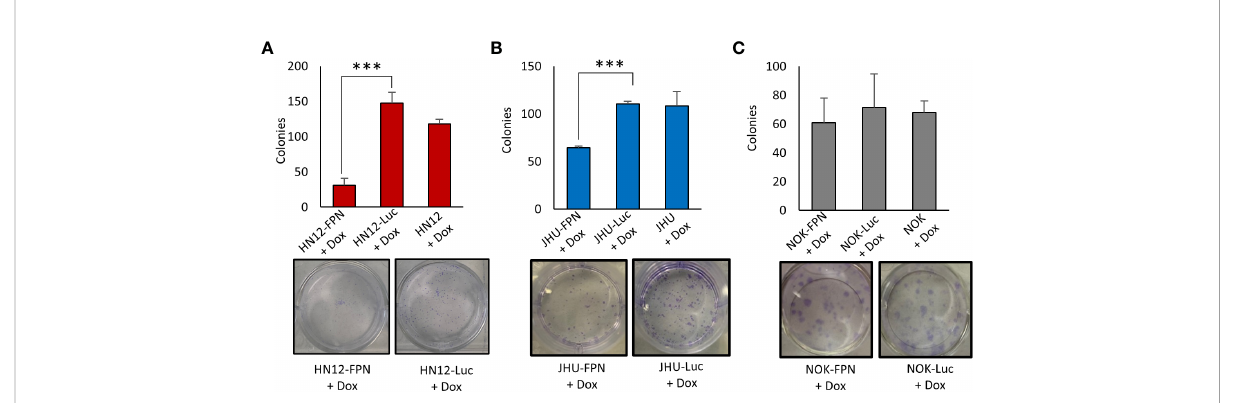
FIGURE 4 Expression of Ferroportin inhibits colony formation of HNSCC cell lines. Clonogenic assay quanti fi cation and a representative plate of HN12 (A) , JHU-022 (B) , and NOK (C) FPN expressing or Luc control expressing cells. Cells were seeded at 250 cells per well with 0.25 m g/mL dox and colonies were counted after 7-8 days. (***P<0.001) Data and images are representative of 3 biological